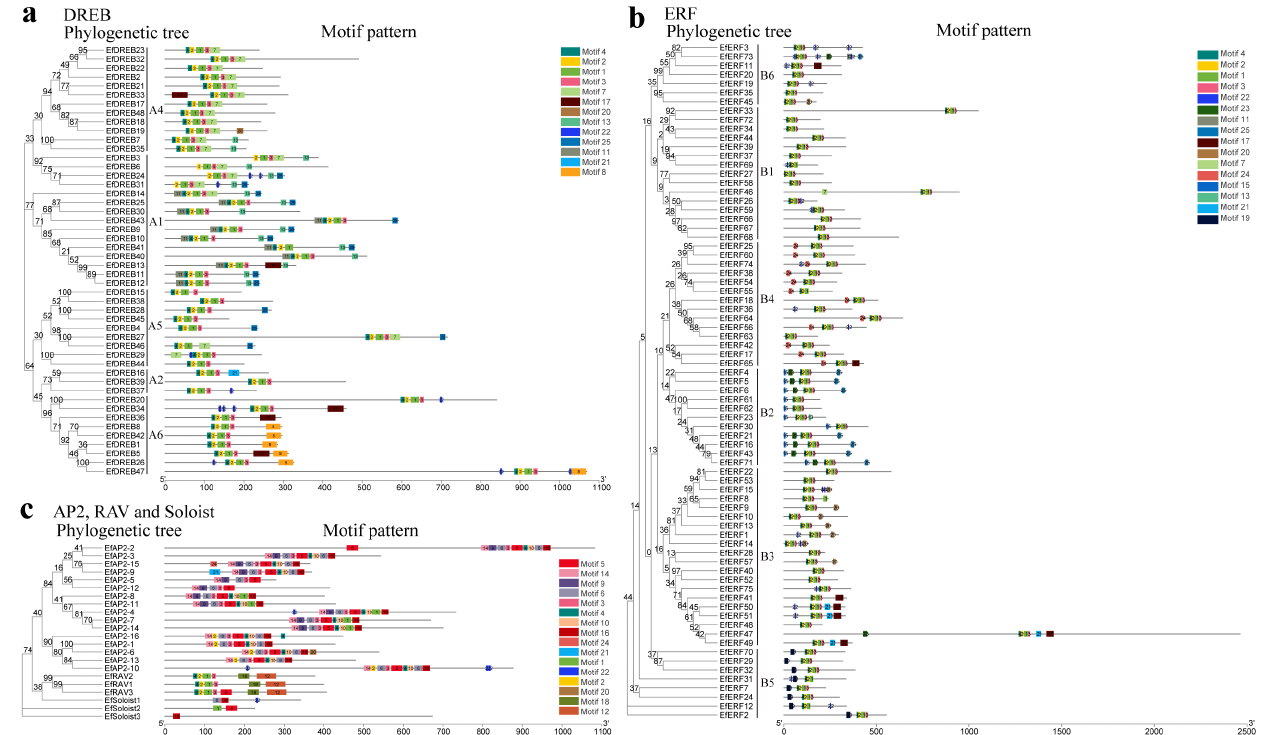
Figure 3. Conserved motif cluster analysis of EfAP2/ERF family genes according to phylogenetic relationships. ( a ) Conserved motif of EfDREB subfamily. ( b ) Conserved motif of EfERF subfamily. ( c ) Conserved motif of EfAP2 , EfRAV , and EfSoloist subfamilies. A total of 25 motifs are displayed in different-colored